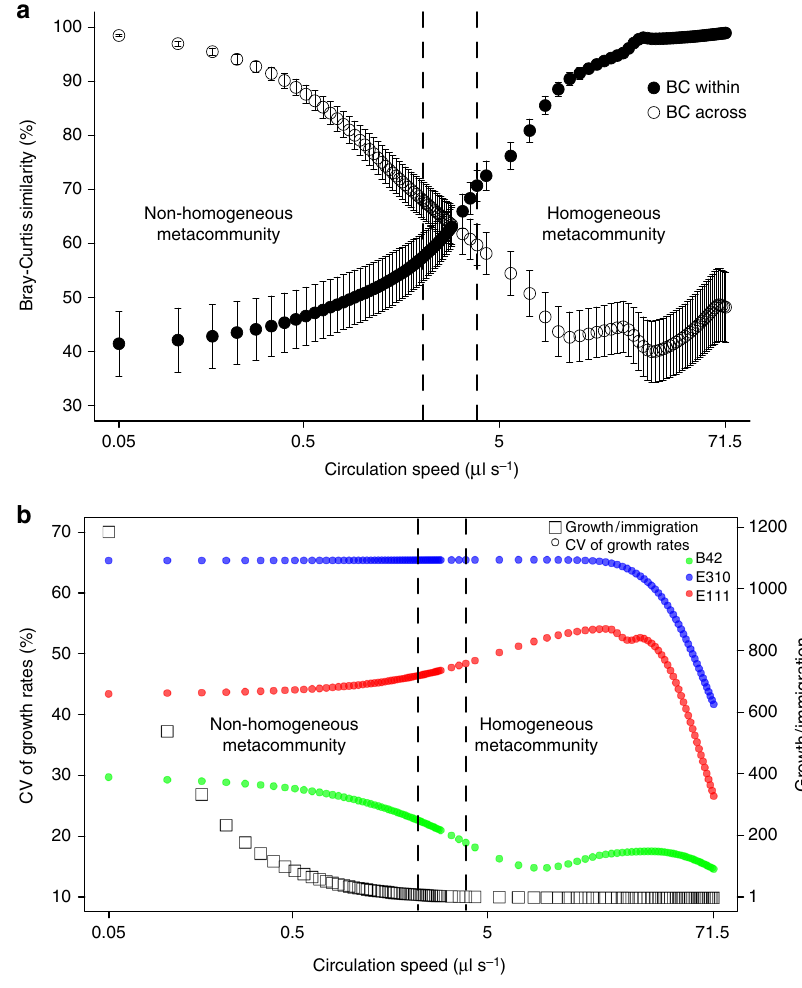
Fig. 5 The modeled changes in community dynamics with increasing dispersal. a Bray – Curtis similarity as a function of increasing circulation speed (in logarithmic scale). Vertical dashed lines delimit the range of dispersal under which “ BC within ” is signi fi cantly lower than “ BC across ” (on the left of the left line) and vice versa (on the right of the right line; generalized linear mixed-effects models, corrected two-sided p < 0.05). Vertical bars represent one standard error ( n = 21). Source data are provided as a Source Data fi le. b The coef fi cient of variation (CV) of the growth rates among the three incubation vessels (left side) and the growth-over-immigration ratio (right side) as a function of increasing circulation speed (in logarithmic scale). The vertical dashed lines are drawn based on